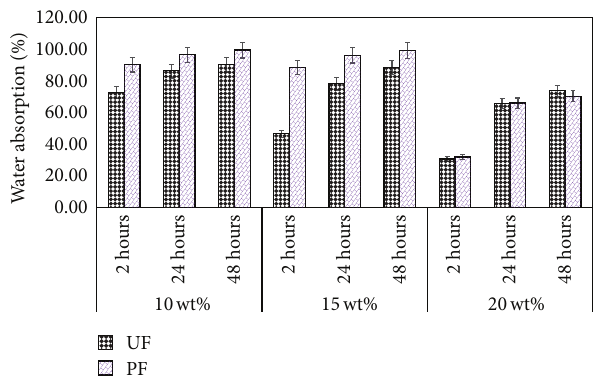
Figure 9: Water absorption of sago particleboard versus resin matrix content